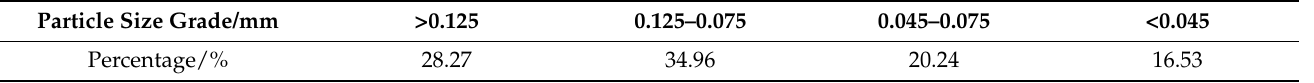
Table 4. The Particle size grade of high carbon fly ash raw